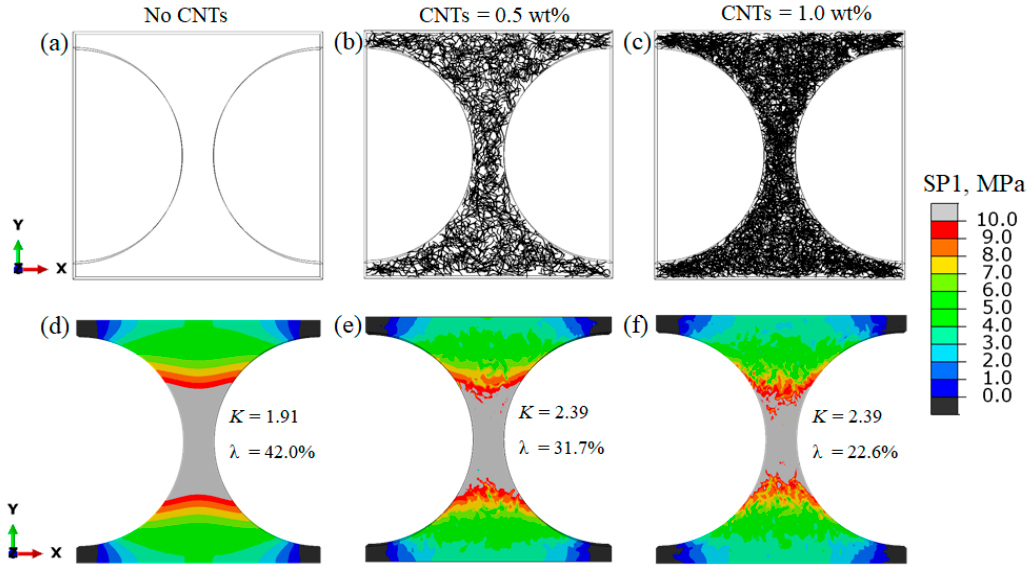
Figure 3. Three types of FRCs: ( a ) pristine (without CNTs), ( b ) reinforced by 0.5 wt% and ( c ) 1.0wt% of CNTs that are homogeneously distributed in the matrix (2D view), and ( d – f ) the stress distribution in the matrix for the cases in ( a – c ), respectively. The externally applied stress is 10 MPa.